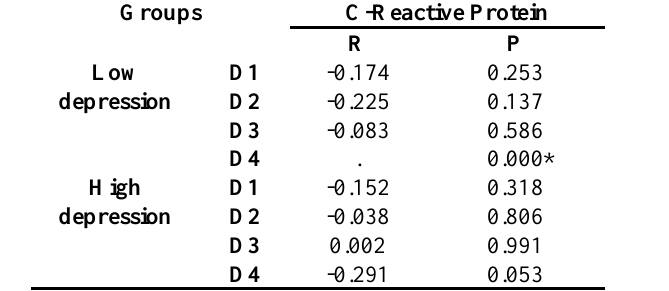
Table 6: Correlation coefficient of caries severity with C-Reactive Protein according to different grade of